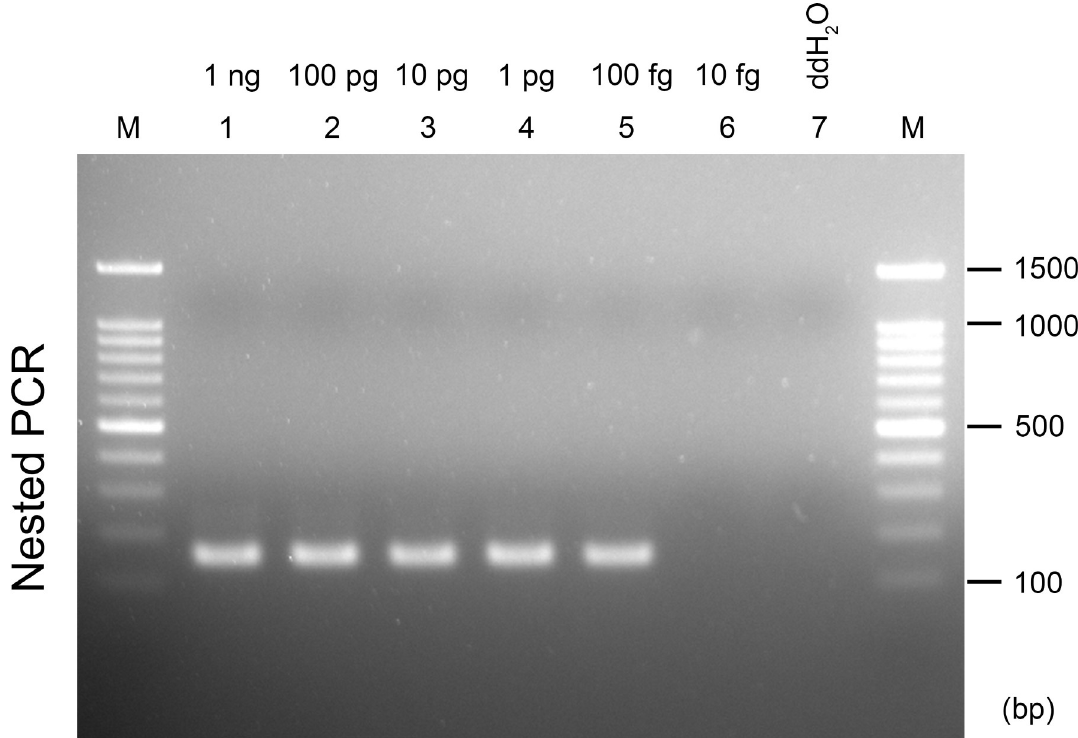
Fig 3. Sensitivity test of the nested PCR assay. Ten-fold dilutions (1 ng to 10 fg) of C . siamense ML133 genomic DNA were used as the template. The nested PCR assay was performed using primers Col_nest-1F/Col_nest-1R for the first PCR, and Col_nest-2F/ Col_nest-2R for the second PCR. M, 100-bp ladder (Faith Biotechnology Co.,